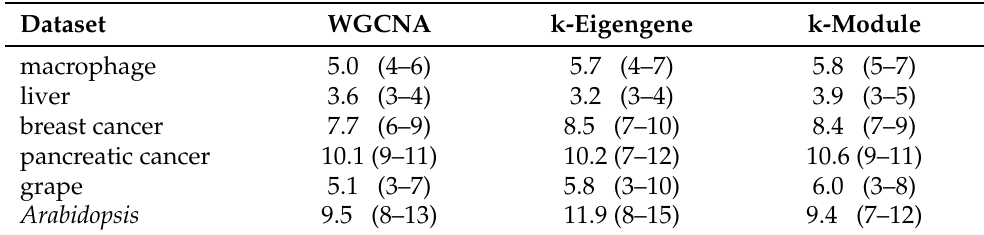
Table 3. The average values and ranges of the numbers of modules with preservation significance greater than 50 among the modules in each of the two